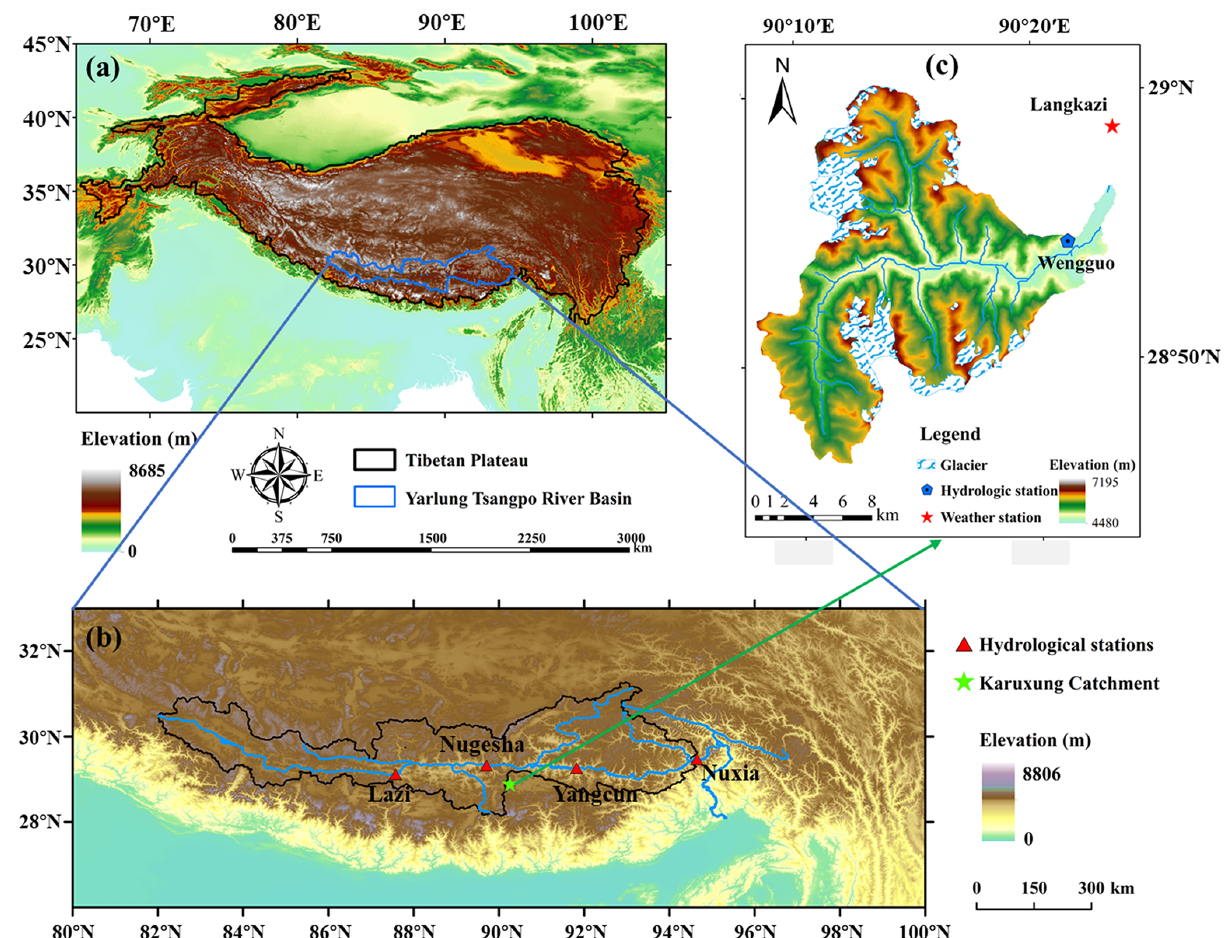
Figure 1. Location and topography of (a) Tibetan Plateau, (b) Yarlung Tsangpo river basin and (c) Karuxung catchment.